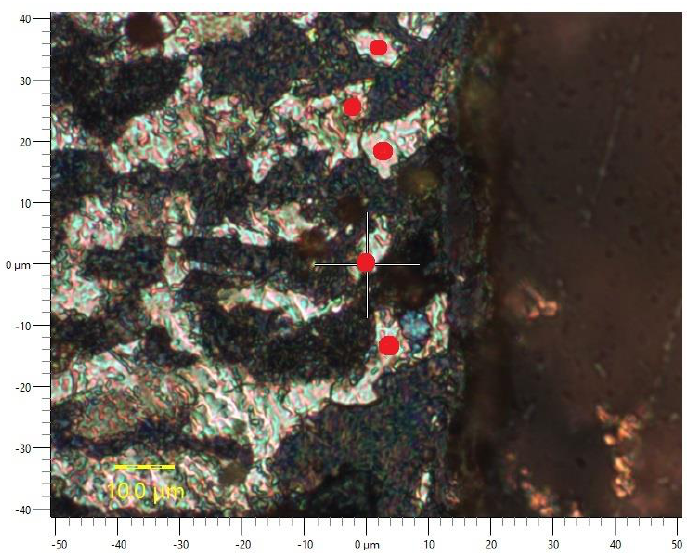
Figure 10. An OM image of the AWJ-cut edge with places where indentations were made.